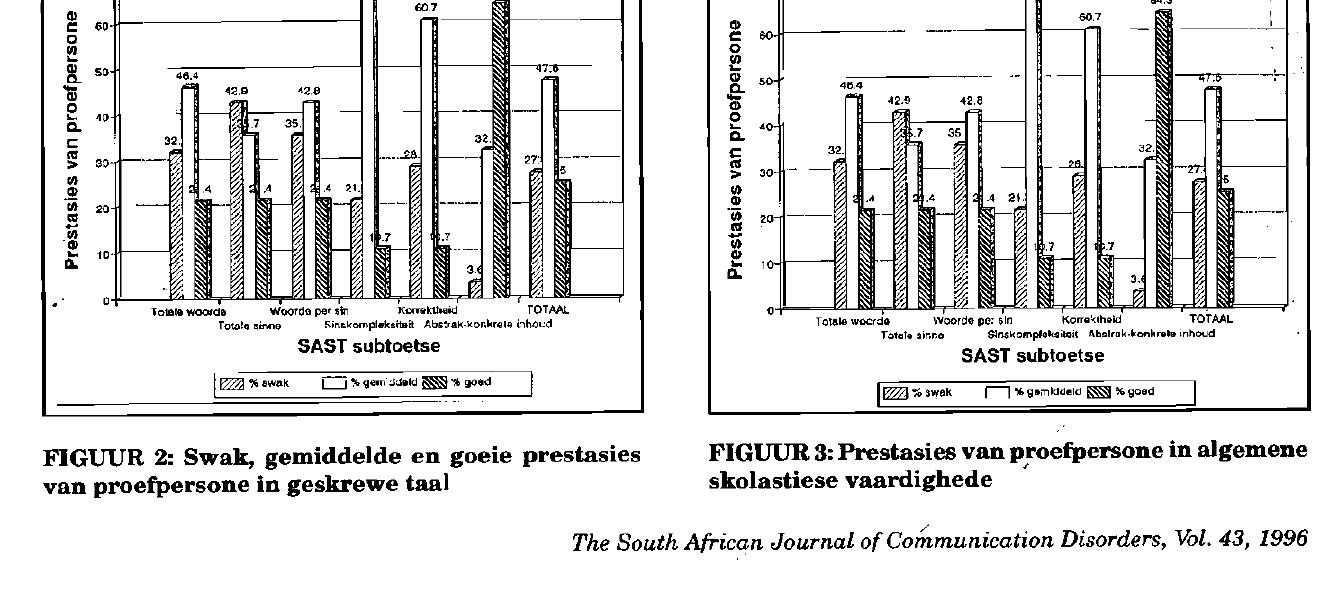
figuur 1). Dit blyk dus dat die proefpersone ten spyte van